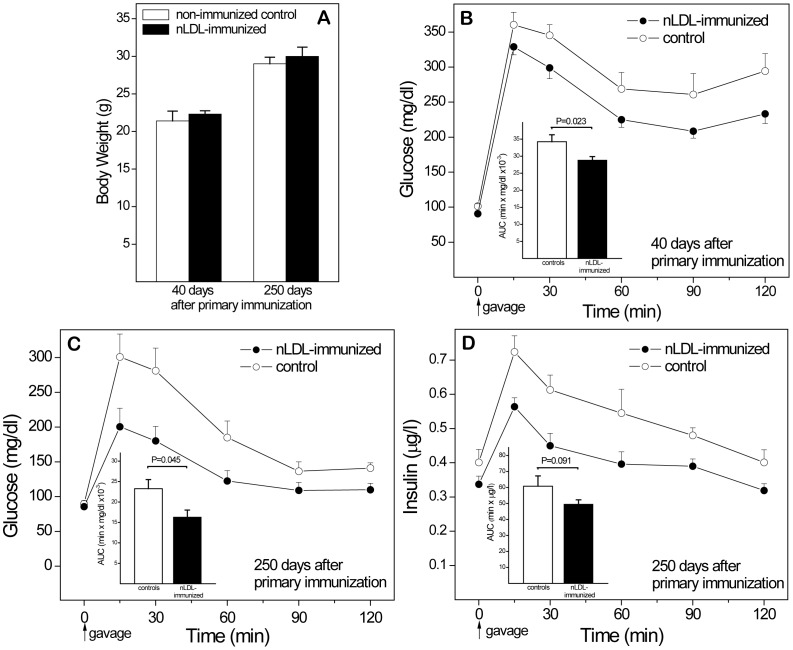
Protective effects of nLDL immunization in euglycemic female mice fed regular chow.To assess direct effects of immunization on glucose responses, OGTTs were performed on separate groups of female mice 40 and 250 days after the primary immunization. Controls were non-immunized. (A) Body weights at both time points. (B) Glucose responses after 40 days. (C,D) Glucose and insulin responses after 250 days. AUC, Area under the curve. n = 24 (40 days) and 25 (250 days).